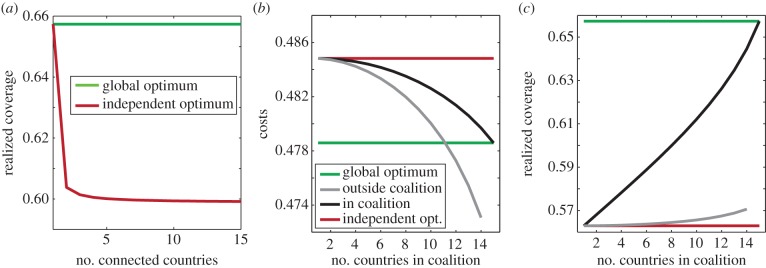
Multi-patch SIR model. (a) Global, fully cooperative optimum (green line) and the independent, non-cooperative optimum (Nash equilibrium), given in red for increasing numbers of identical interconnected countries. Parameters: R0 = 5, coupling strength = 10μ/(n − 1), ai = 0.1, cIi = 5. Costs (b) and realized coverage (c) for a system of 15 identical interconnected countries, for increasing coalition size (x-axis). Green and red lines show global and independent optima (as in (a)), black lines show the optimum realized by the countries in the coalition, grey lines show optimum for countries that have not joined the coalition. Other parameters as in (a).